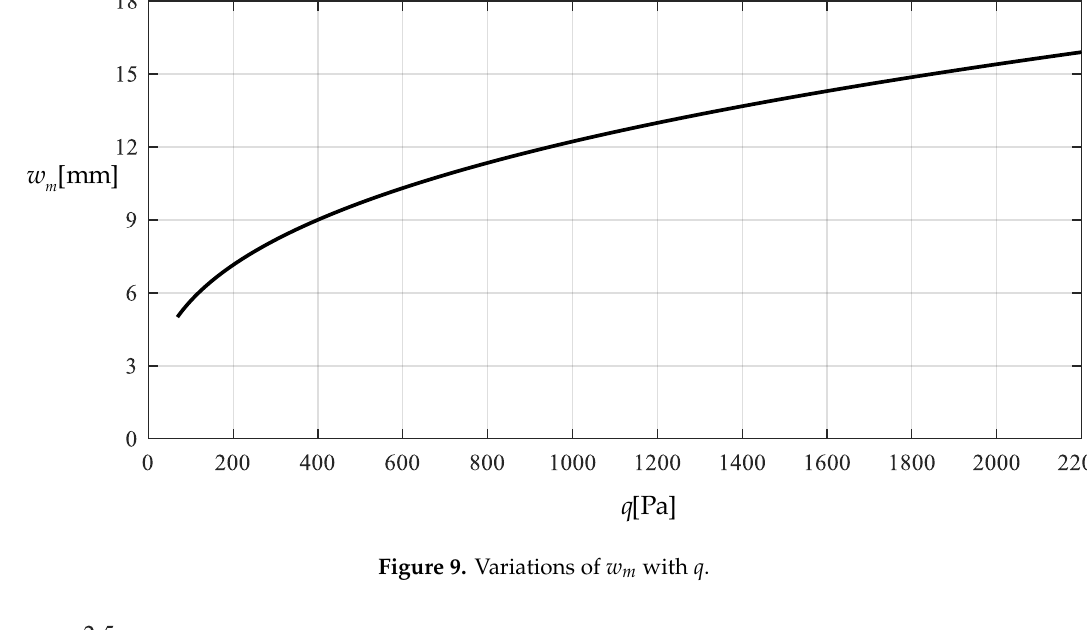
Figure 9. Variations of w m with q .